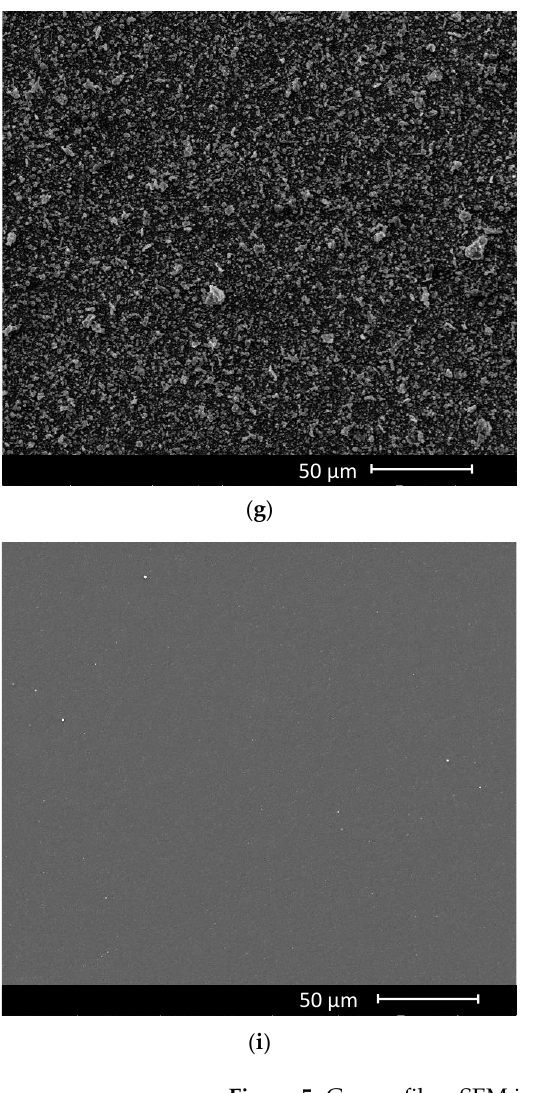
Figure 5. Grown films SEM images of MAPLE ( a , b ), PLD 1064 ( c , d ) and PLD 532 nm ( e , f ).Grown films SEM images of PLD 355 nm ( g , h ) and PLD 193 nm ( i , j ).